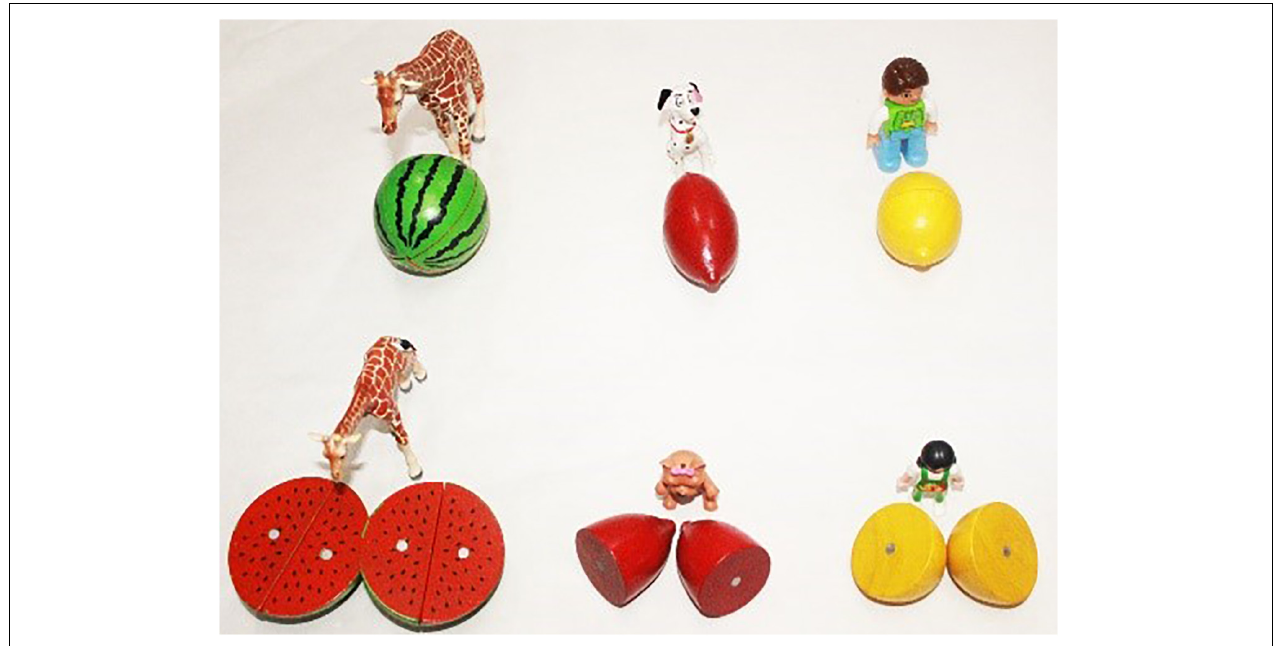
FIGURE 8 | Last scene of the story of the Partial Object Condition.